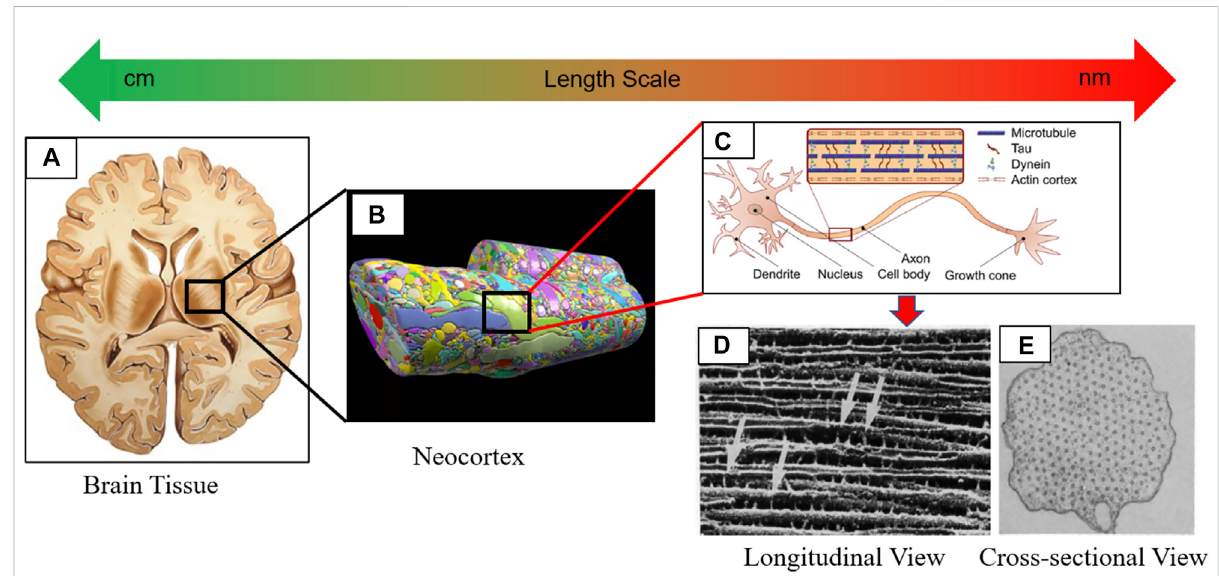
FIGURE 1 Depicting multiscale hierarchical structure of the brain tissue ranging from macroscale tissue to microscale neuronal cells. (A) Cross-sectional view of the brain tissue (gray and white matter) in the horizontal plane. (B) Reconstruction of the neocortex shows the heterogeneity posed by neuronal cells and ECM (Kasthuri et al., 2015). (C) Anatomy of the neuronal cell (de Rooij et al., 2017). (D) SEM image shows how axially oriented MT arecross-linkedwiththeTau. (C) Across-sectionalviewofthetransverseplaneshowsthehexagonalorientationofMT. (C – E) areadaptedfrom (Chen et al.,